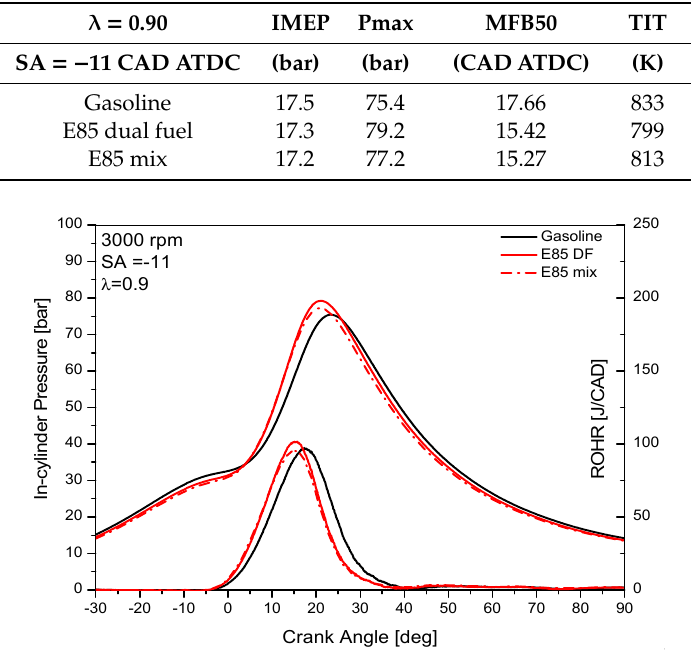
Figure 2. In-cylinder pressure and rate of heat release in Cyl. #2 for different injection conditions at SA = − 11 CAD ATDC and λ = 0.9.